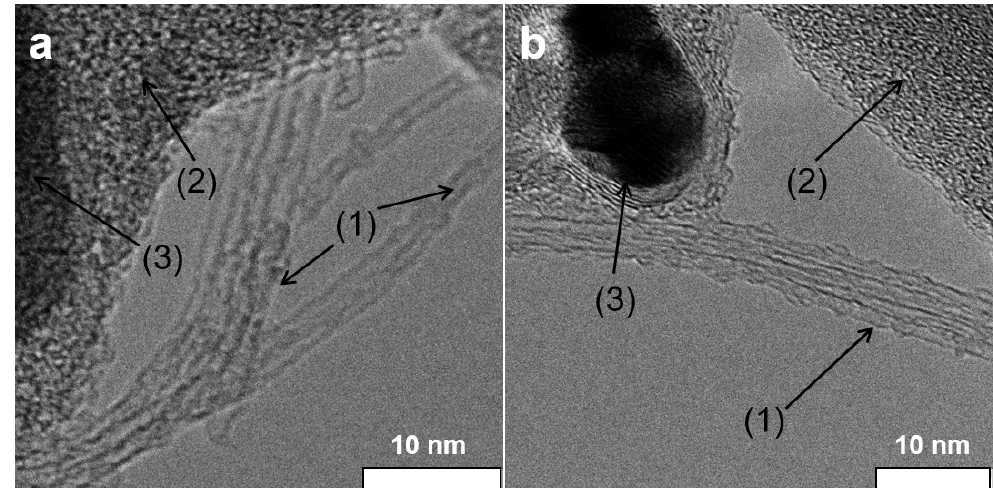
Figure 4. High resolution transmission electron microscopy images of ( a ) undoped SWCNTs and ( b ) Li@SWCNTs washed in deionized water (1). Besides the tubes, samples contained amorphous carbon (2) and core-shell structures of catalyst particles (3).